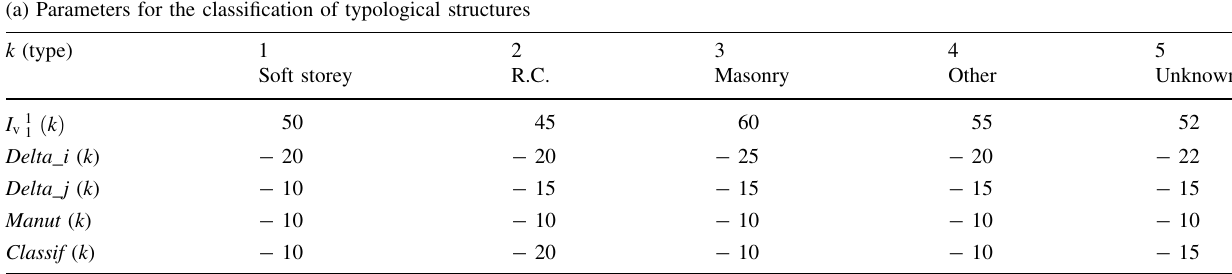
Table 2 Elements for the vulnerability assessment method based on the 1991 ISTAT data. Source Bernardini et al. (2008) (a) Parameters for the classification of typological